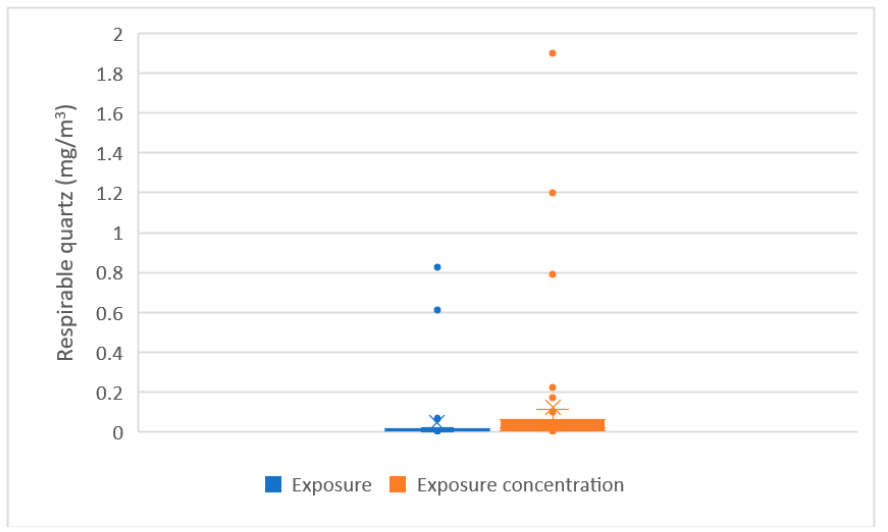
Figure 8. The effectiveness of using respirators during dusty activities. Reproduced with permission from Tuomi et al., Finnish Institute of Occupational Health, 2022 [34].